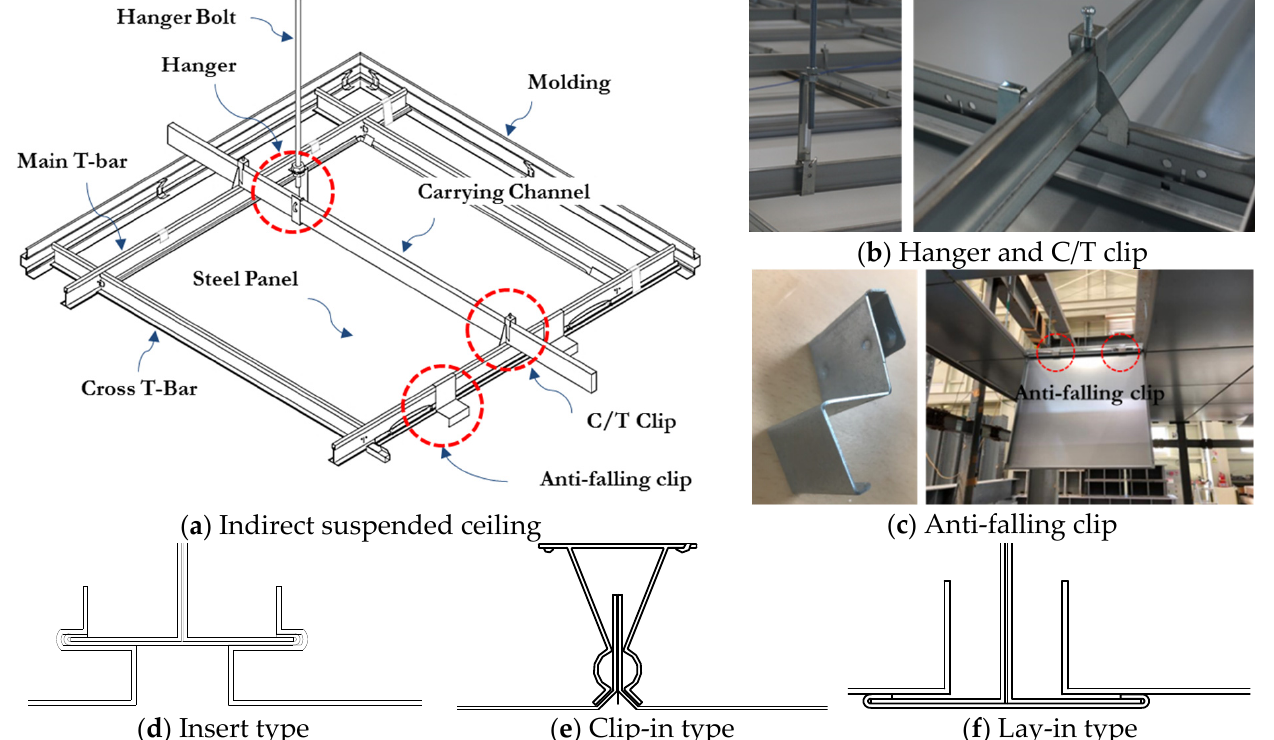
Figure 3. Suspended ceiling system with steel panel in Korea (indirect suspended ceiling). ( a ) Suspended ceiling system with steel panel, ( b ) hanger and carrying channel/T-bar clip (C/T clip), ( c ) anti-falling clip, ( d ) insert type of panel, ( e ) clip-in type of panel, ( f ) and lay-in type of panel.